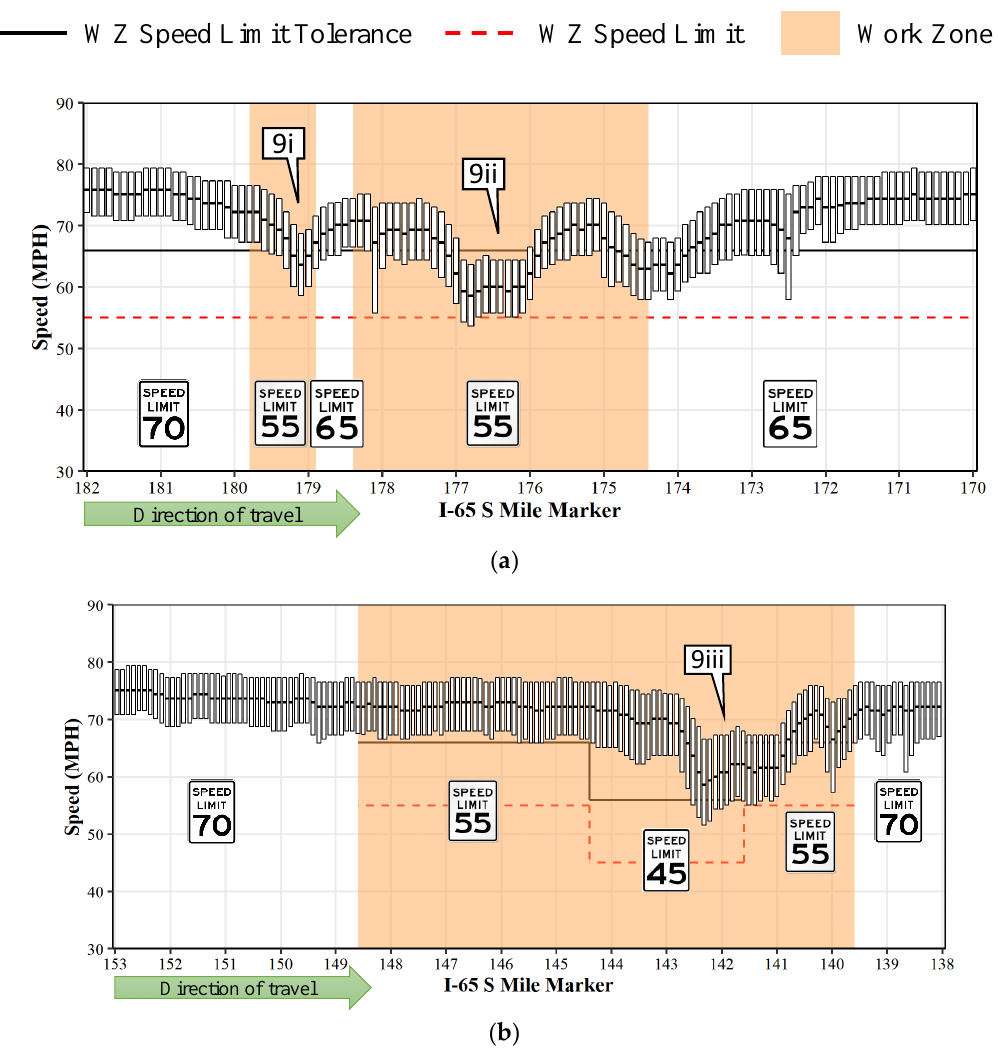
Figure 9. IQR speed plots for non-enforcement work zones. ( a ) I-65 Sa WZ MM 182 to MM 170, IN during July 2021. ( b ) I-65 Sb WZ MM 153 to MM 138, IN during May 2021. Callouts 9i-9iii shows the speed reductions due to geometric constraints.